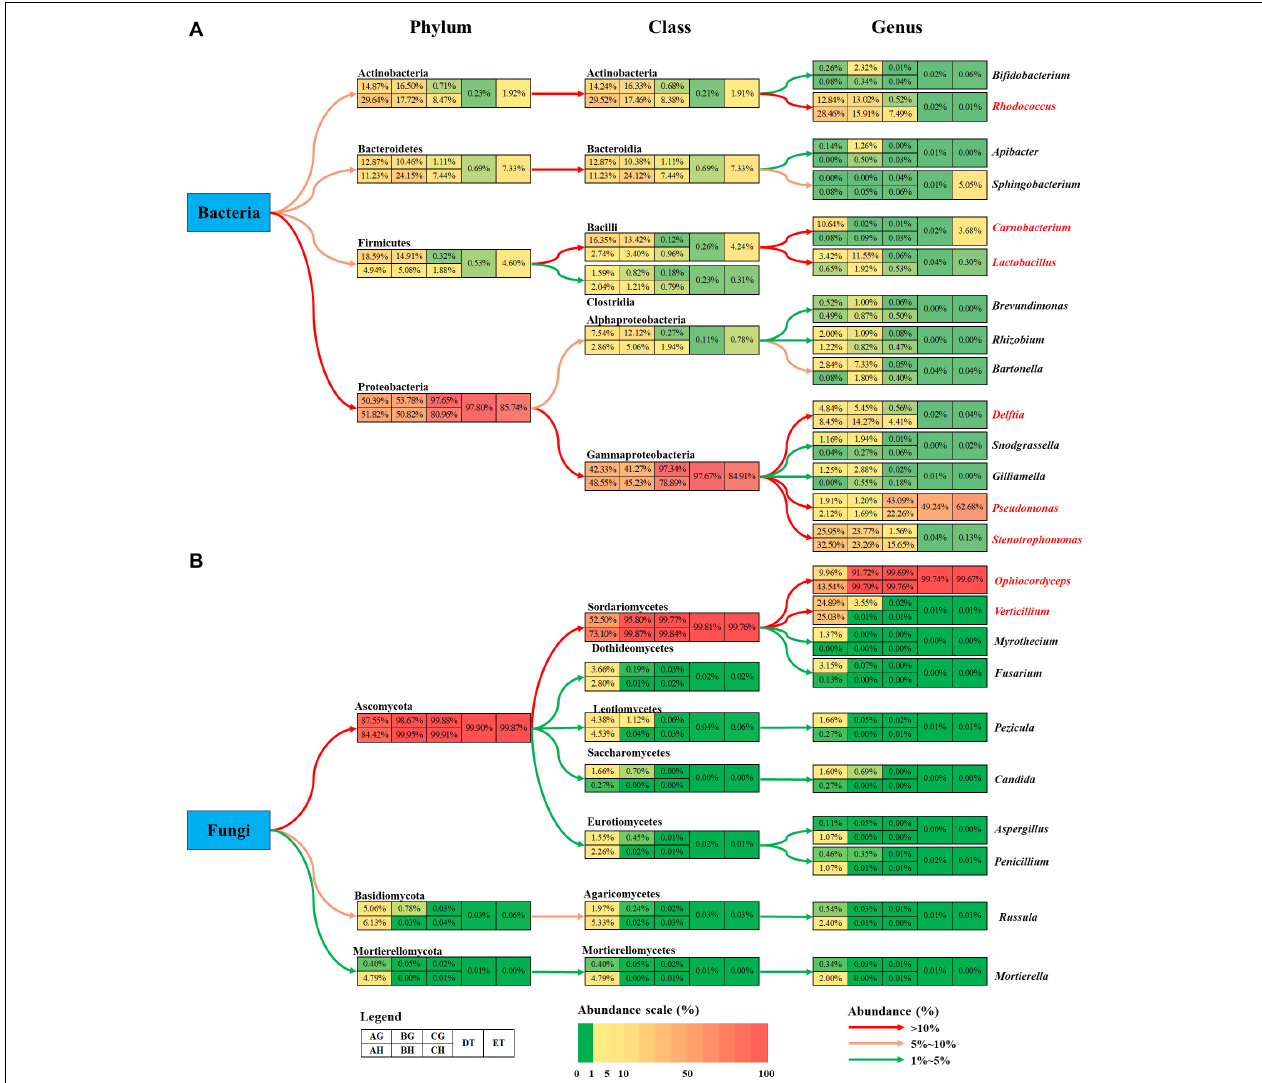
FIGURE 6 | Summary of the changes in bacteria (A) and fungi (B) community among eight types of samples. The colored boxes represent corresponding samples according to the legend. Relative abundance is indicated by color gradients; the color from green through yellow to red represents the value from low to high. Colored arrows show the abundance changes from higher taxonomic level to lower level. AH and AG, hemolymph and gut of un-injected living larvae; BH and BG, hemolymph and gut of living larvae with a high blastospore load; CH and CG, freshly mummifying larvae without mycelia coating; DT, tissues of the mummified larvae coated with mycelia; ET, tissues of the completely mummified larvae with